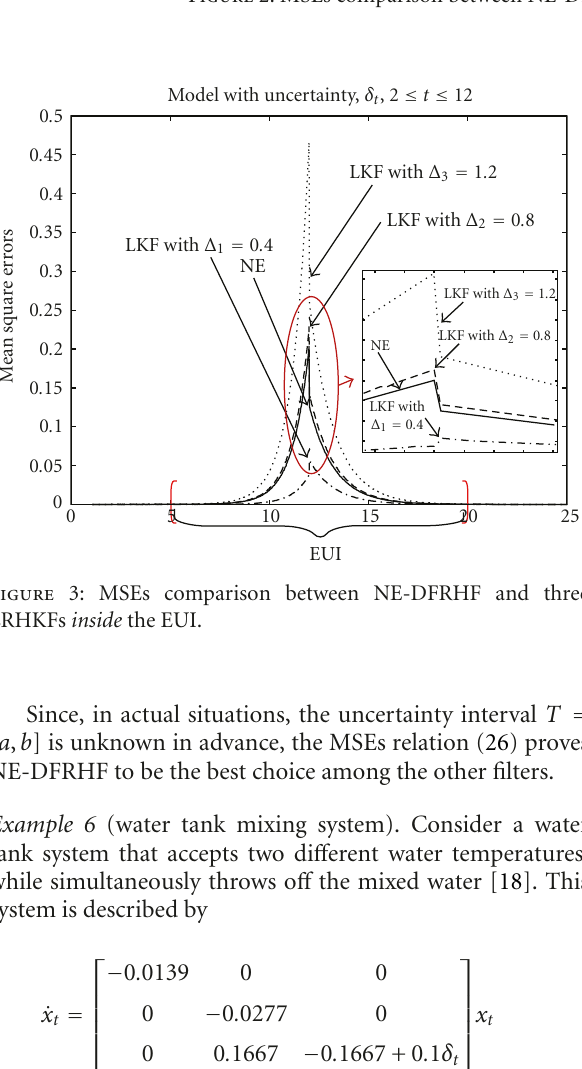
Figure 2: MSEs comparison between NE-DFRHF and three EQ-DFRHFs before and after EUI.